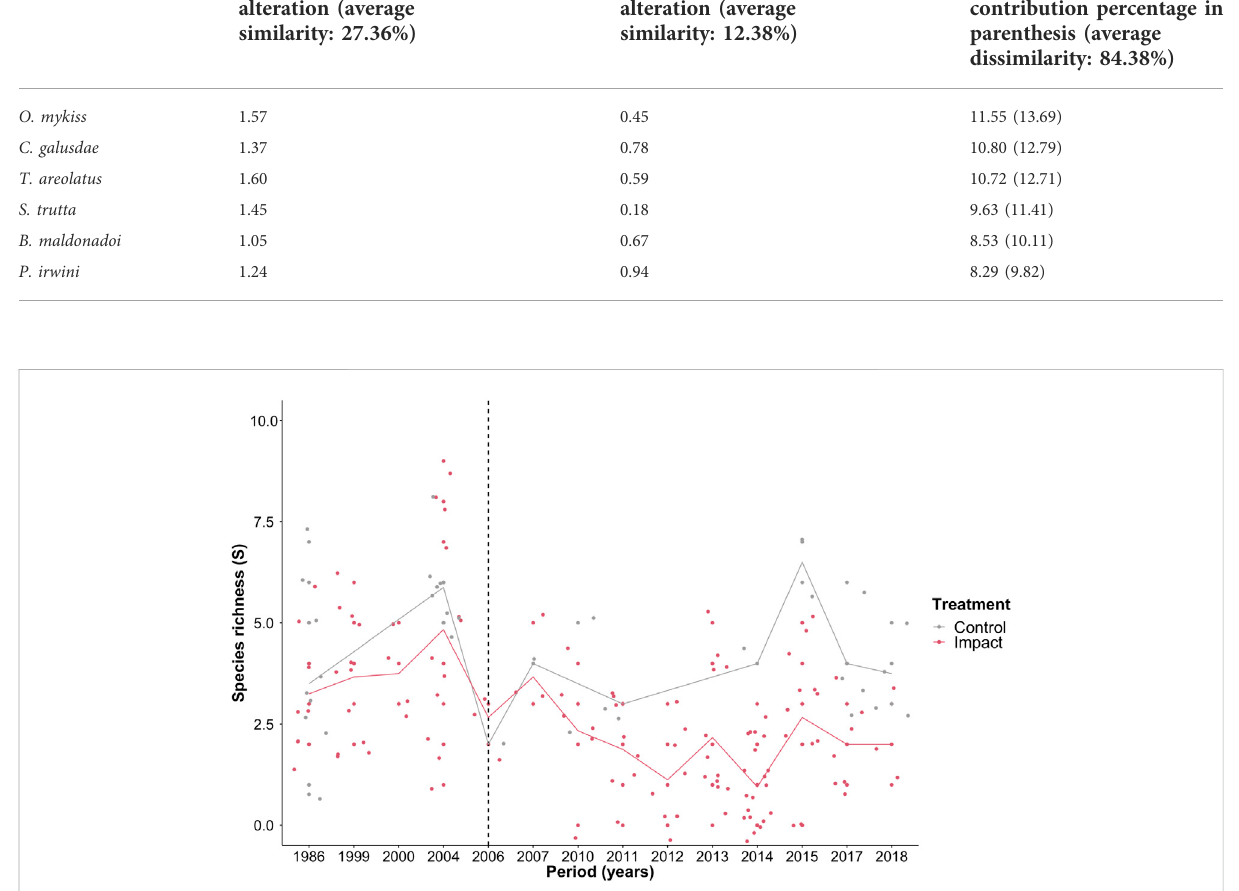
FIGURE 5 Richness of native species at impacted and control sites from Andalién river before and after started fl uvial works of DFWAR project from 2006 (dashed line). Graycircles (control sites) and red circles (impact sites) show species richness ineach site. Solid lines are moving average for each year for control and impact